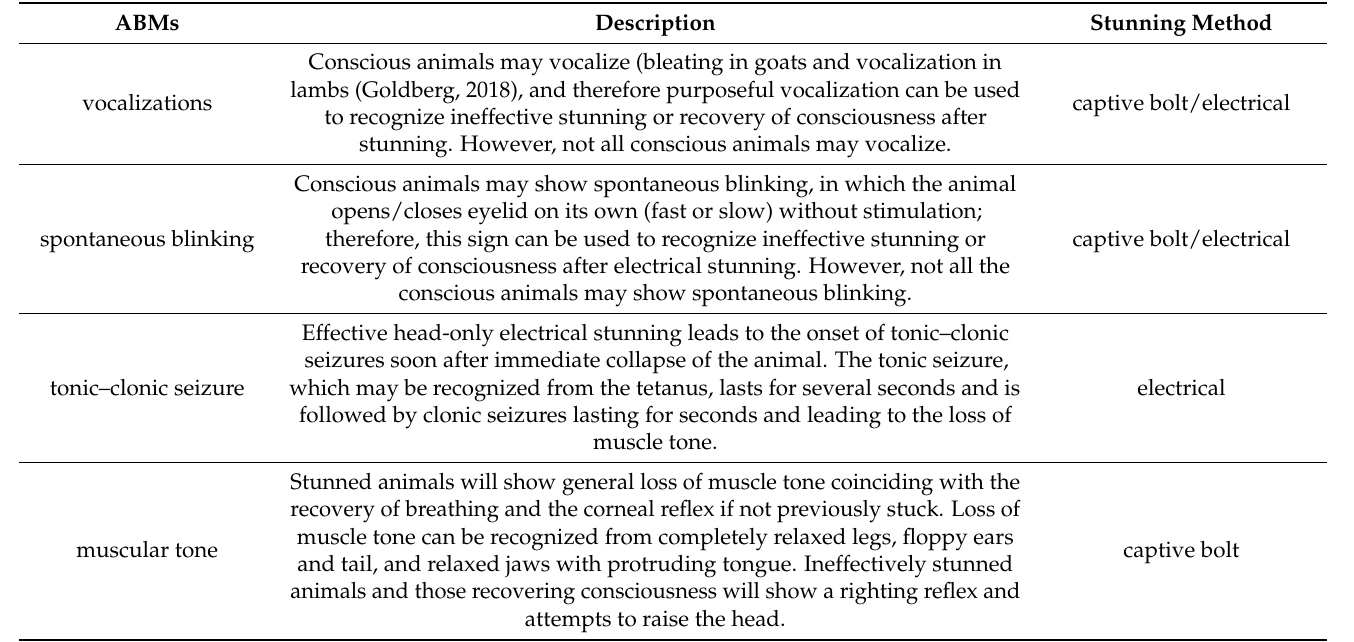
* Table adapted from EFSA, Scientific Opinion (2021)